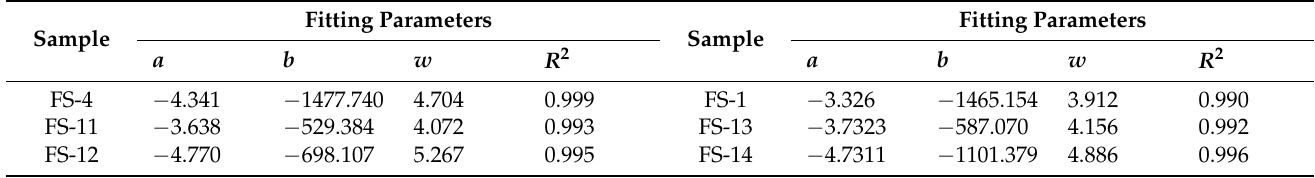
Figure 8. Relationship between water imbibition content and time. Table 4. Fitting results of parameters during imbibition test ( R 2 is the correlation coefficient).